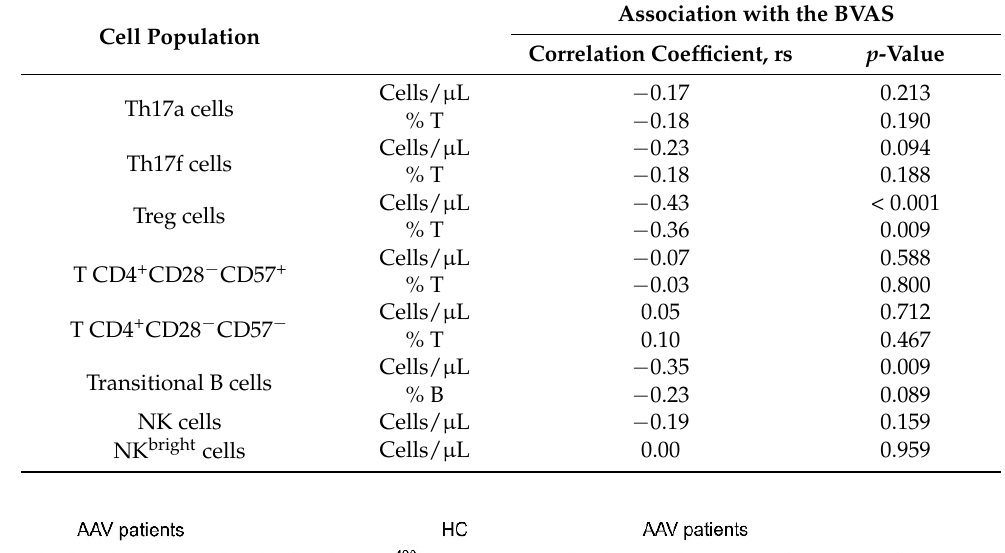
Table 6. Relationship between the AAV-related immune fingerprint cell populations and the disease activity in the patients group.